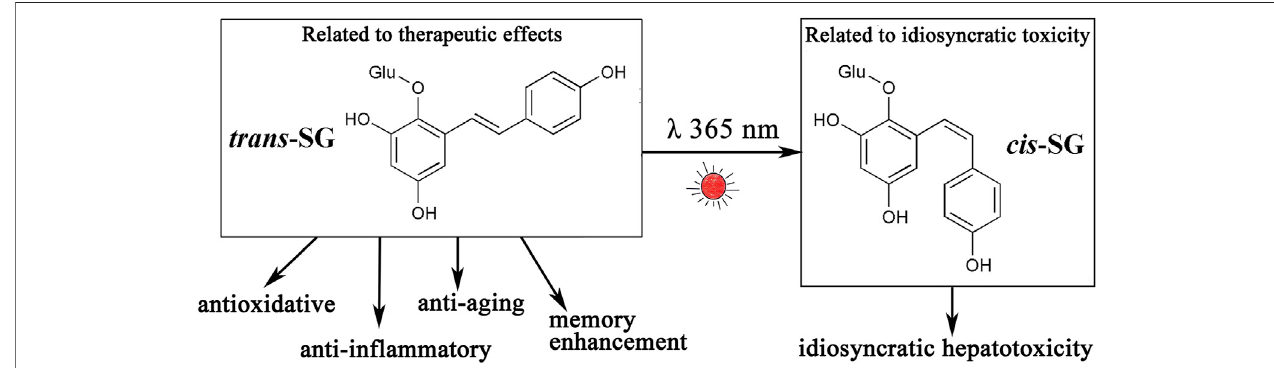
FIGURE 3 | Trans -SG can be transformed into its cis -isomer ( cis -SG) by ultraviolet light or sunlight. Trans -SG is a component responsible for therapeutic effects, however, cis -SG is an idiosyncratic hepatotoxic component. Abbreviations: trans -SG, trans -2,3,5,4 ’ -tetrahydroxystilbene-2-O- β - glucoside; cis -SG, cis -2,3,5,4 ’ - tetrahydroxystilbene-2-O- β -glucoside.